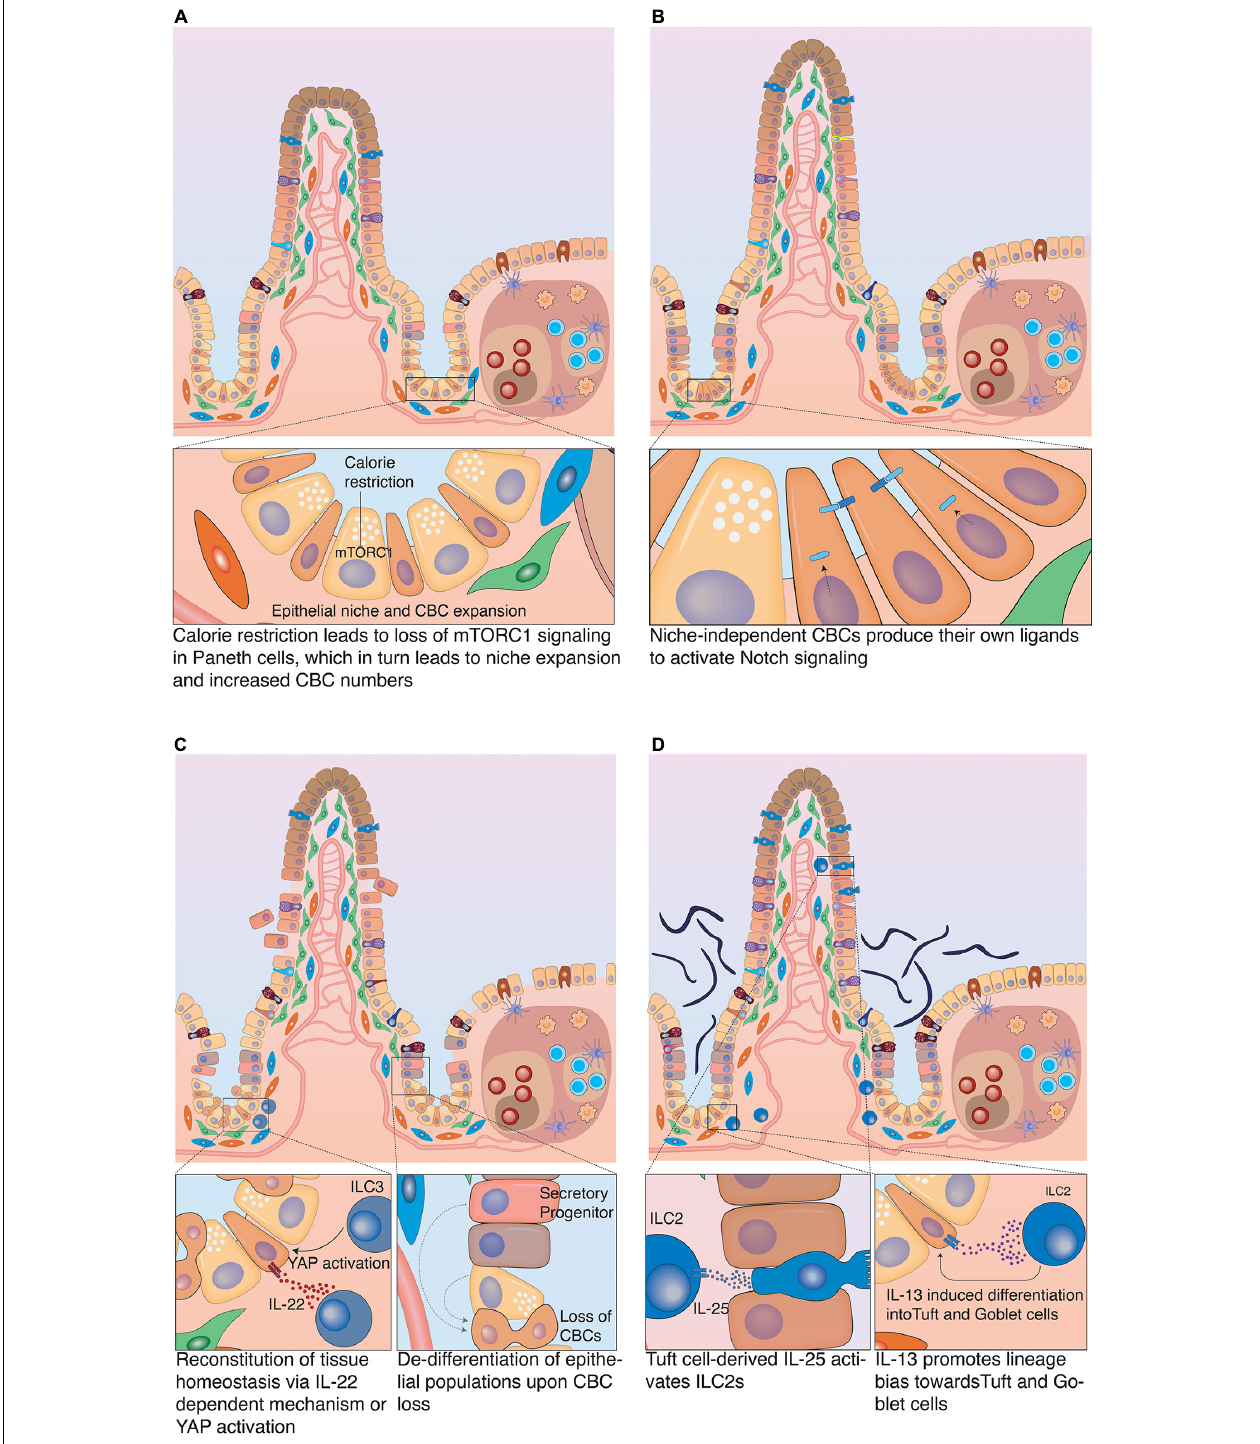
FIGURE 5 | Plasticity of the intestinal epithelium upon different challenges. (A) Calorie restriction. Long-term fasting induces morphological changes in the intestine associated with reduced villus-length. It also affects the stem cell zone, by inducing an increase in the populations of CBCs and Paneth cells and decrease in TA cells. (B) Nutrient overabundance. High-fat diet affects the stem cell compartment, as it induces an increase in the number of CBCs and decrease in Paneth cells. This was linked to the acquisition of Notch independence by CBCs as they produce their own Notch ligands to stimulate Notch signaling. (C) Damage-induced plasticity. Severe damage of the epithelium can lead to profound inflammation that in turn activates group 3 innate lymphoid cells (ILC3), which produce IL-25 to